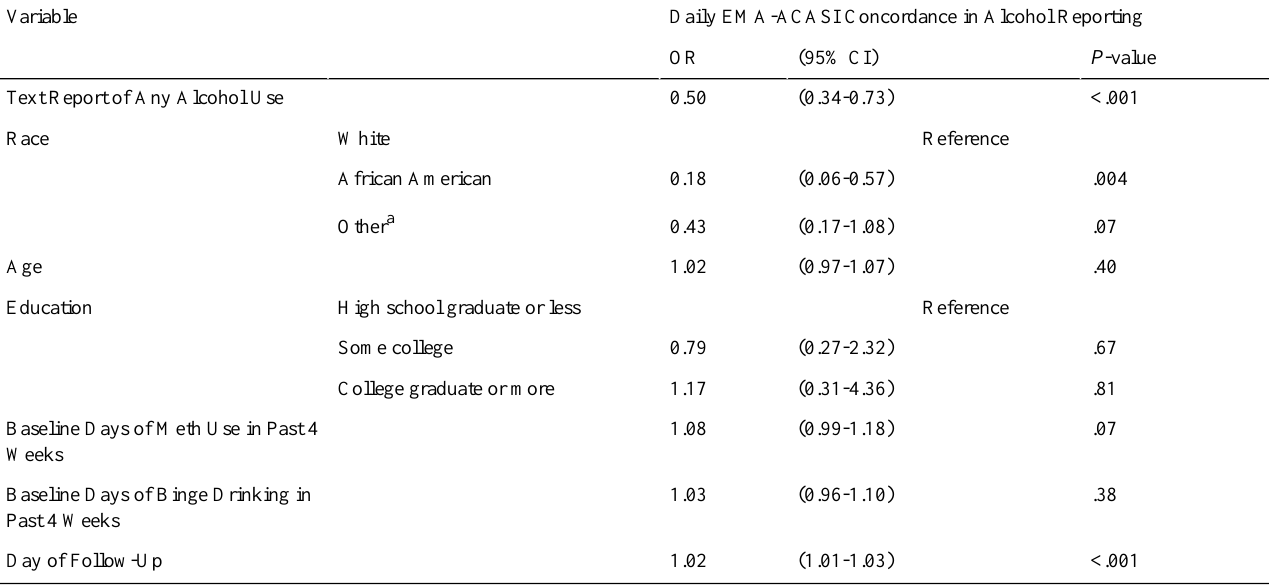
Table 4. Multivariable logistic regression model, fit with generalized estimating equations, assessing daily EMA-ACASI concordance in alcohol reporting